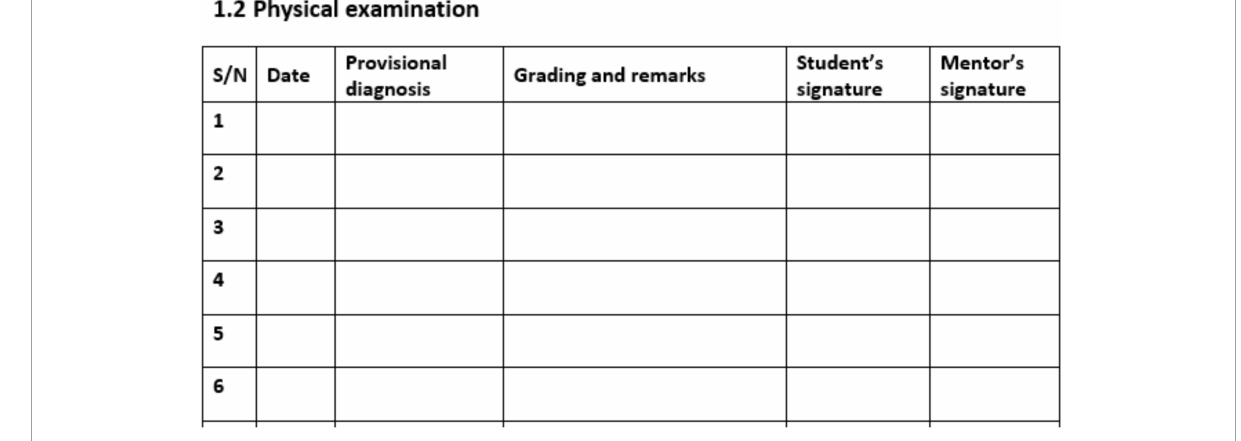
FIGURE1 An exemplary page out of the ML paper-based logbook, showing the provision to provide a date, provisional diagnosis, grading and remarks, student’s signature, and mentor’s